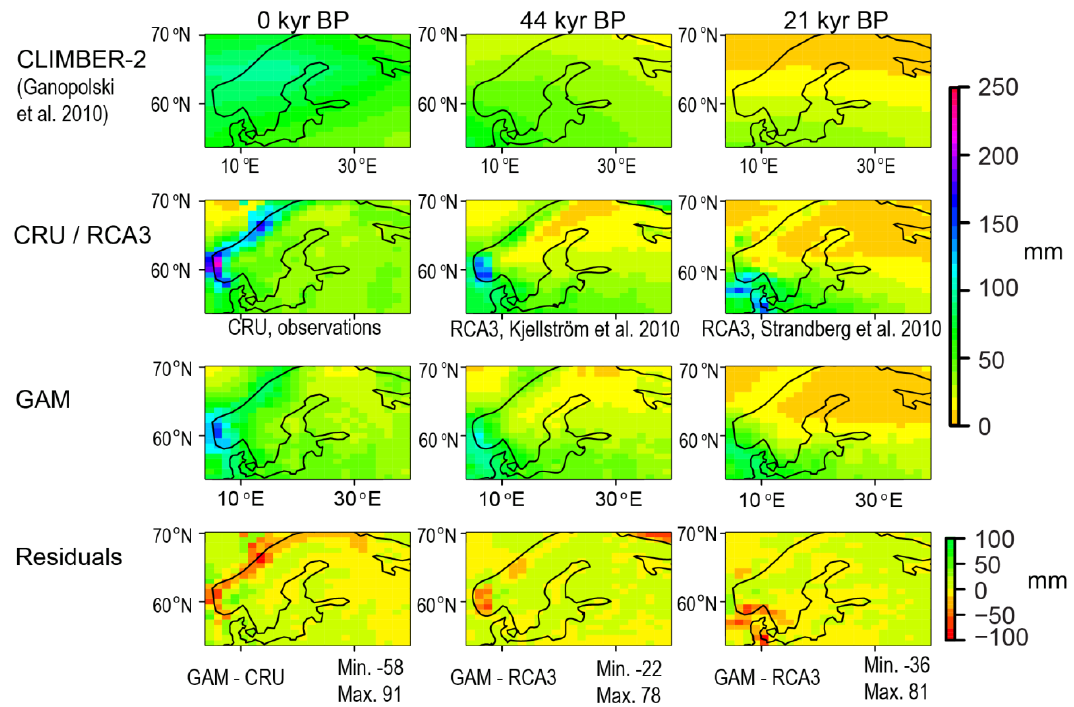
Figure 3. January mean total precipitation at 0 (left column), 44 (middle column) and 21kyr BP (right column) as simulated by the global model CLIMBER-2 (top row), as observed during the period 1961–1990 by the CRU (first figure of the second row), as simulated by the regional model RCA3 (second and third figures of the second row), as predicted by the GAM model (third row), and as the difference between the statistical model and observation/simulation (bottom row). The unit is millimetres. The data of the first and the second rows have been bilinearly interpolated to a 1.5 ◦ × 0.75 ◦ resolution.